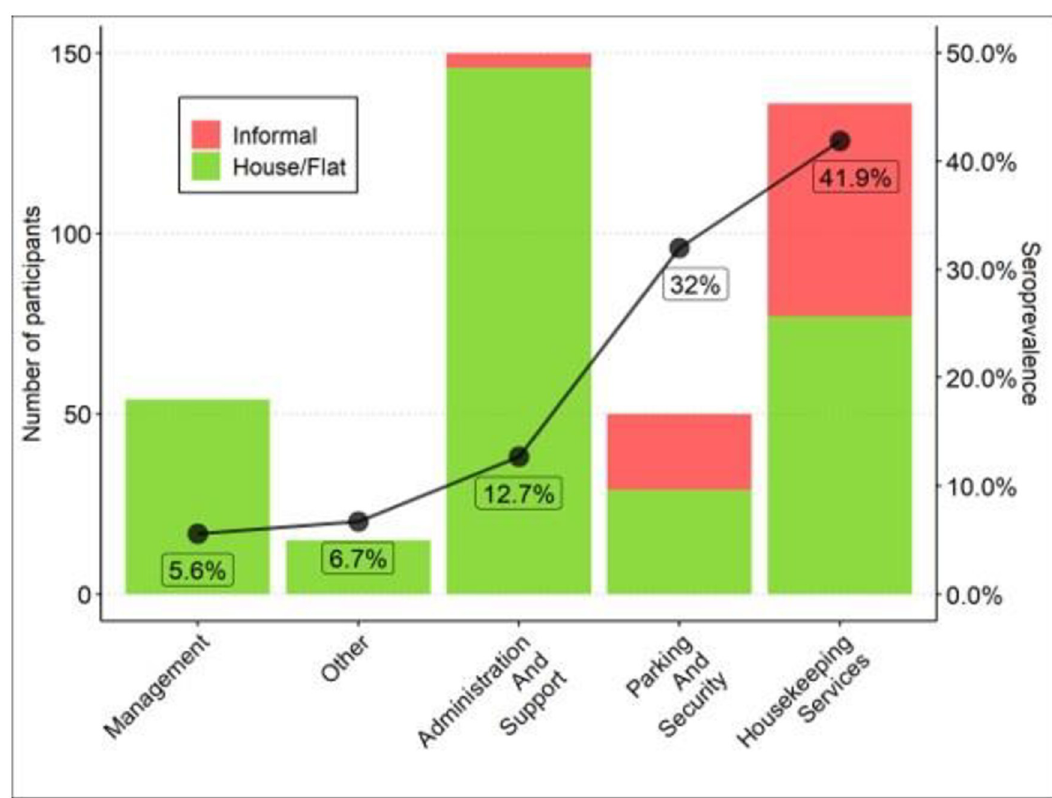
Fig 2. The association between participants’ occupations, type of dwelling and SARS-CoV-2 seroprevalence. There is a higher seroprevalence in lower-earning occupation groups with a higher proportion of participants living in informal